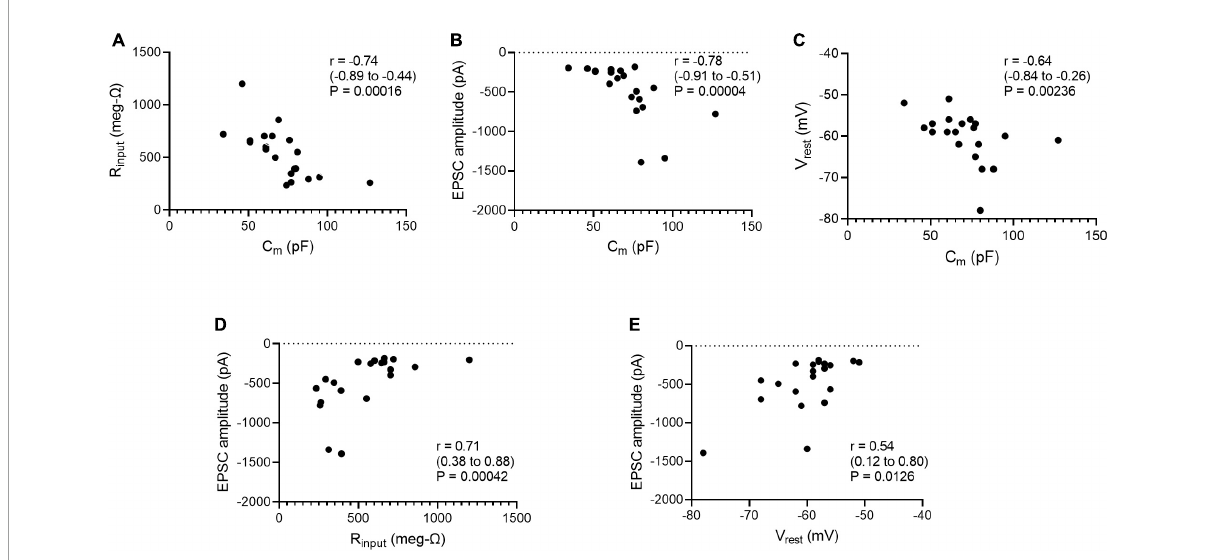
FIGURE5 Whole cell capacitance correlates with (A) input resistance, (B) peak excitatory postsynaptic current (EPSC) amplitudes at straddling synapses, and (C) resting membrane potential. Peak EPSC amplitudes at straddling synapses correlate with (D) input resistance and (E) resting membrane potential. C m was taken as a measure of cell size. Spearman correlation coefficients (r) were calculated for each scatter plot along with 95% confidence intervals and 2-tailed P -values. C m , R input , and EPSCs were measured under voltage-clamp. V rest was measured under-current clamp. All data are from Table 2